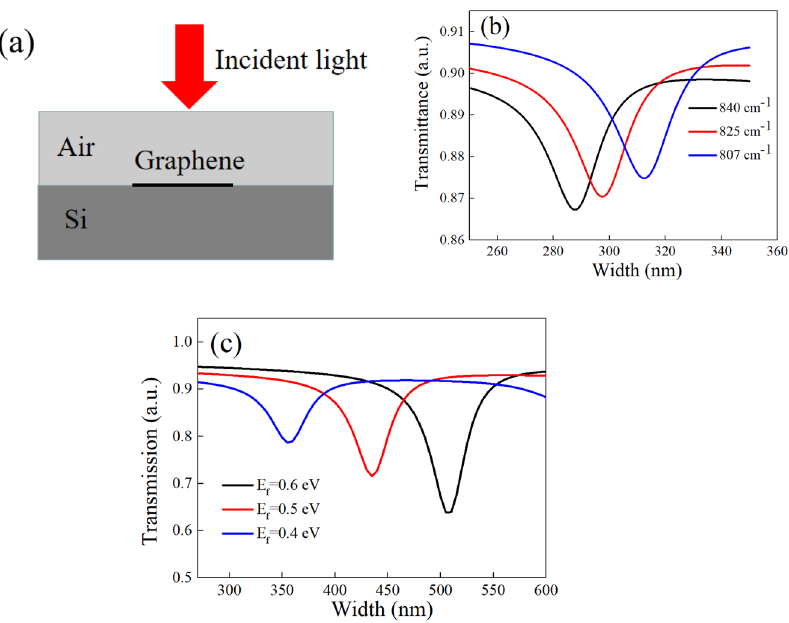
Figure 5. ( a ) The schematic of simulation. ( b ) The transmission versus the width at the frequency of 840, 825 and 807 cm −1 respectively ( c ). The transmission versus the width at different Fermi